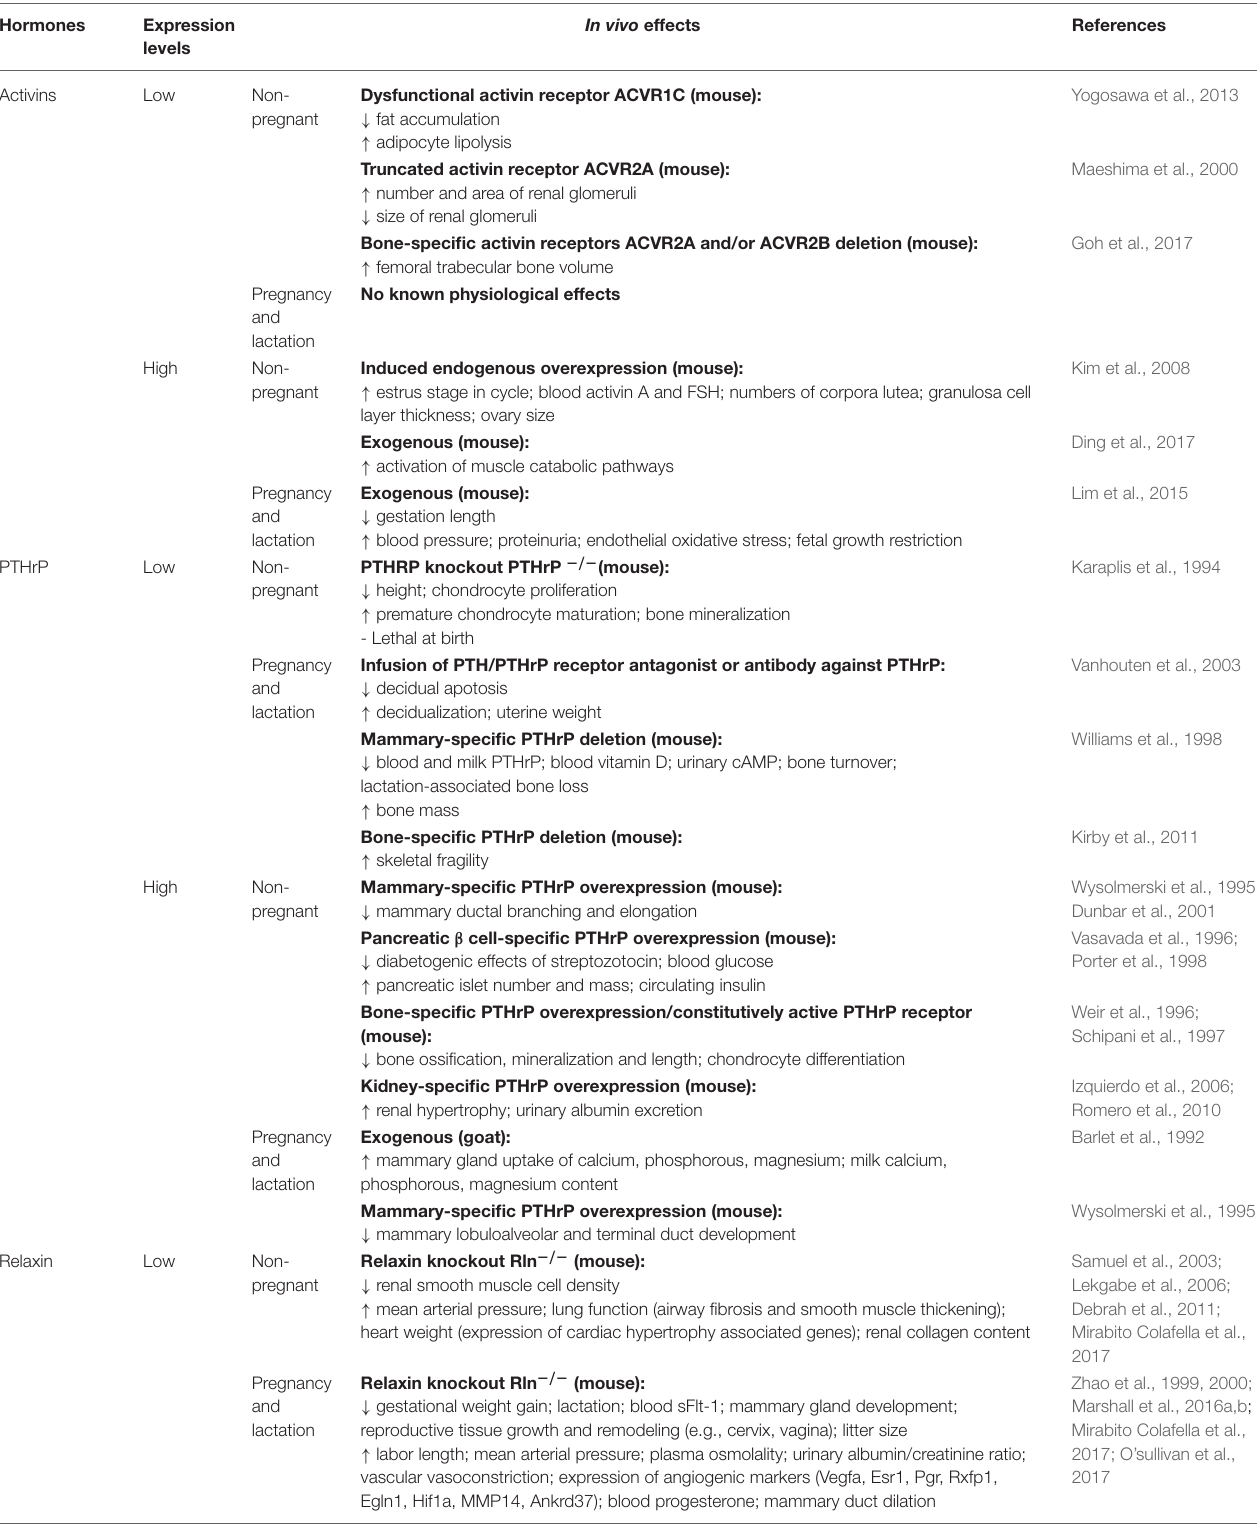
TABLE 7 | Effects of additional hormones in vivo